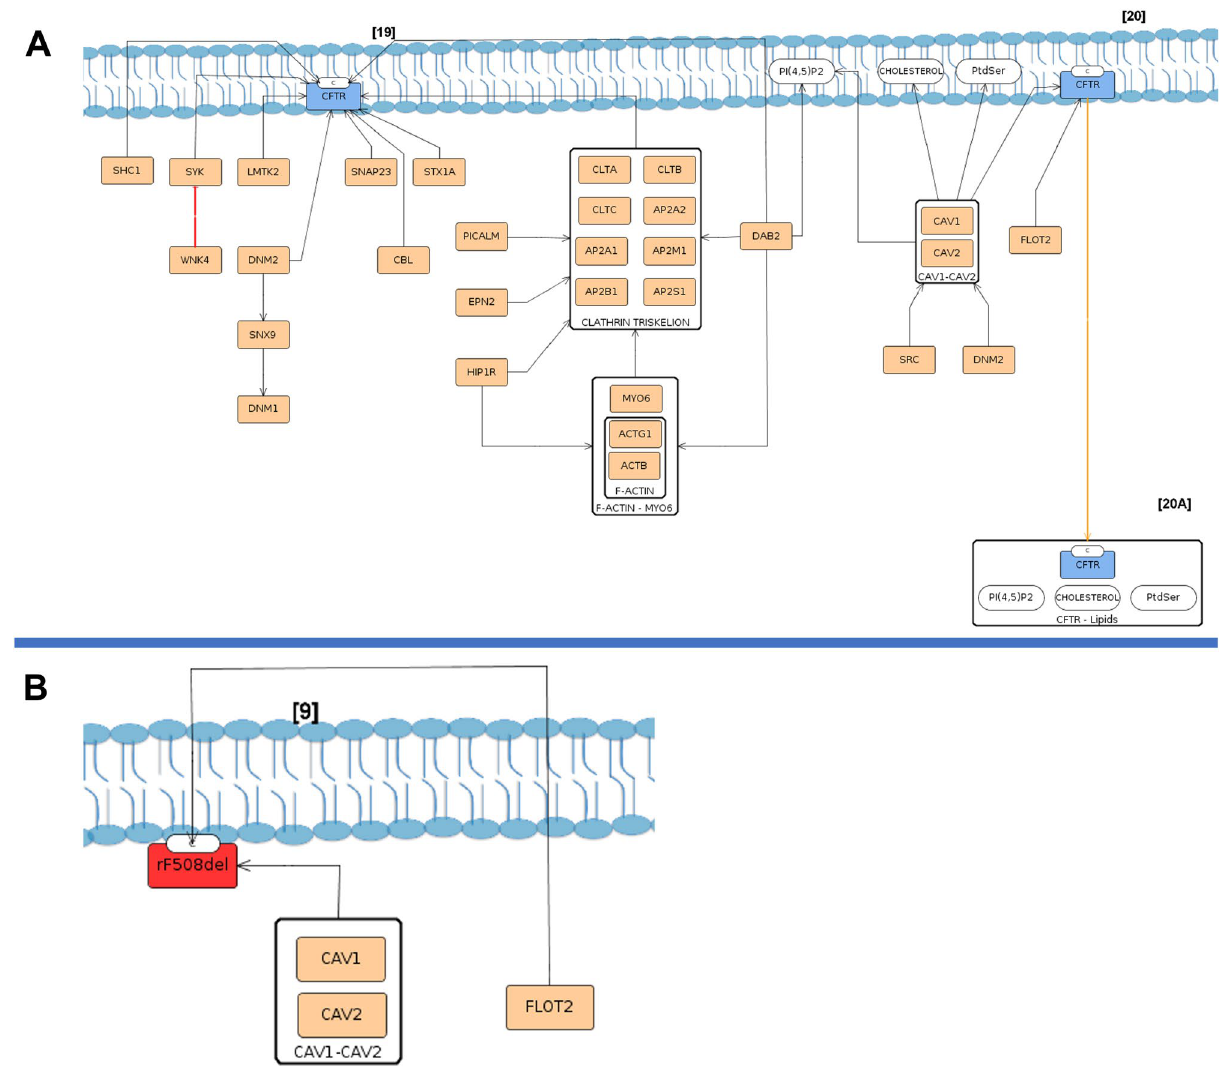
Figure 6. wt-CFTR ( A ) and rF508del-CFTR ( B ) endocytosis mechanisms of internalization from the PM. In the image A two types of internalization of wt-CFTR are present, through clathrin coated vesicles [19] and through caveolae vesicles [20]. As is represented, in the first, several proteins are involved, since the clathrin triskelion complex to cytoskeletal F-actin-MYO6 complex and other proteins assisting the process. In rF508del- CFTR, only the complex Caveolin 1 (CAV1)/ Caveolin 2 (CAV2) was found in this protein endocytosis [9], with assistance of Flotillin 2